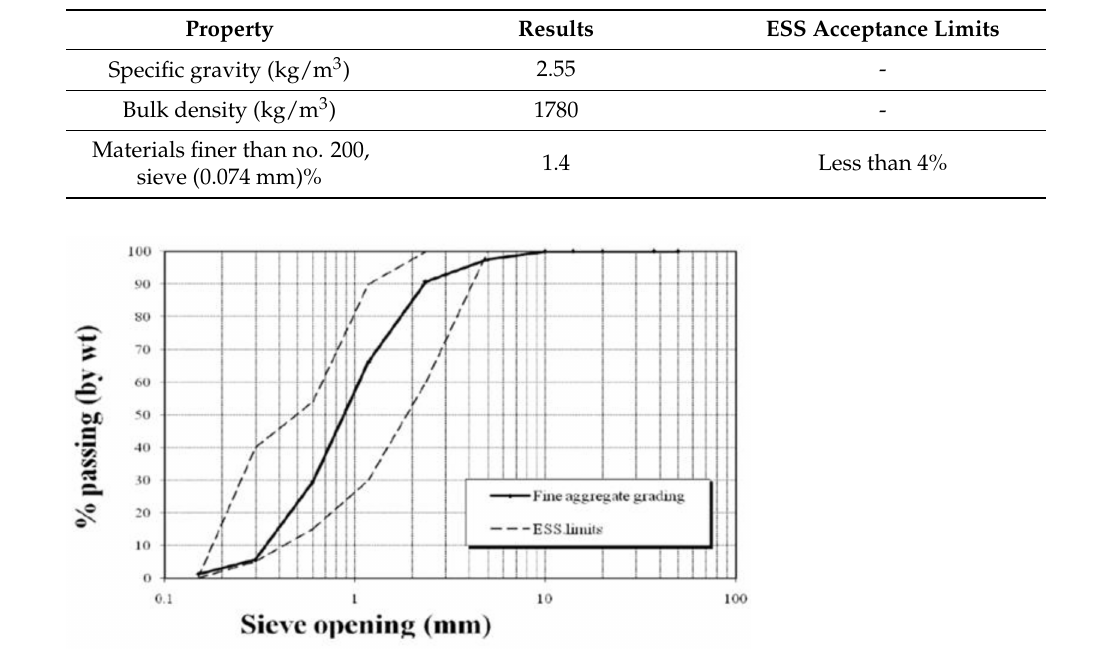
Table 1. Physical properties of the sand.